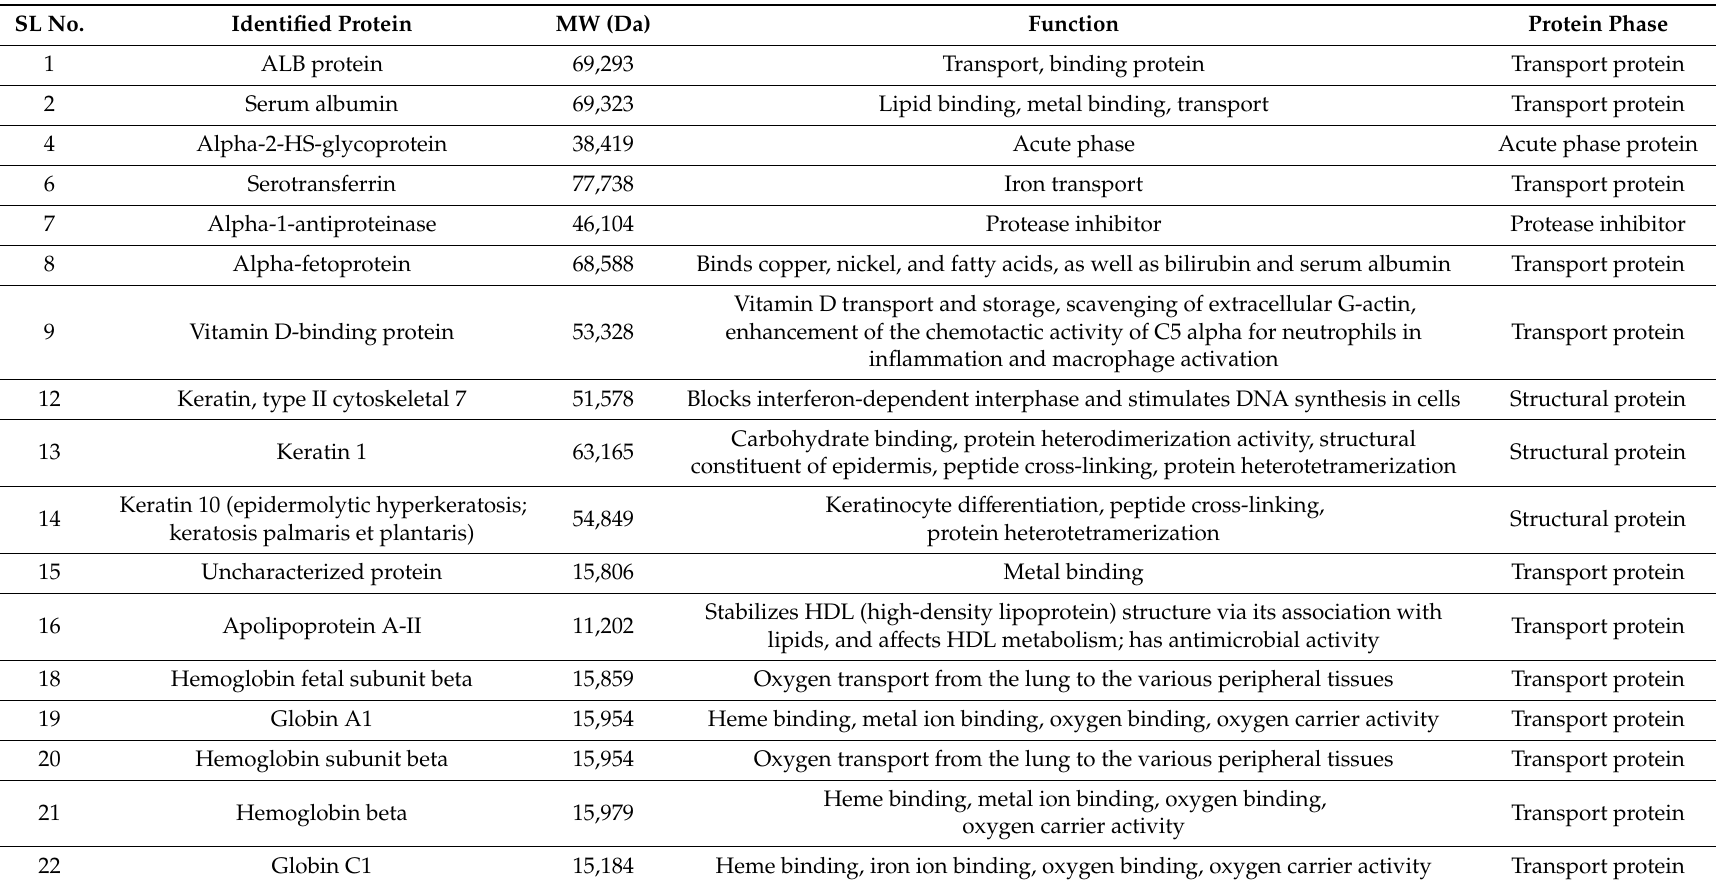
Table 7. List of identified proteins around CA, CMCA, and α -KAMCA NPs in 10%